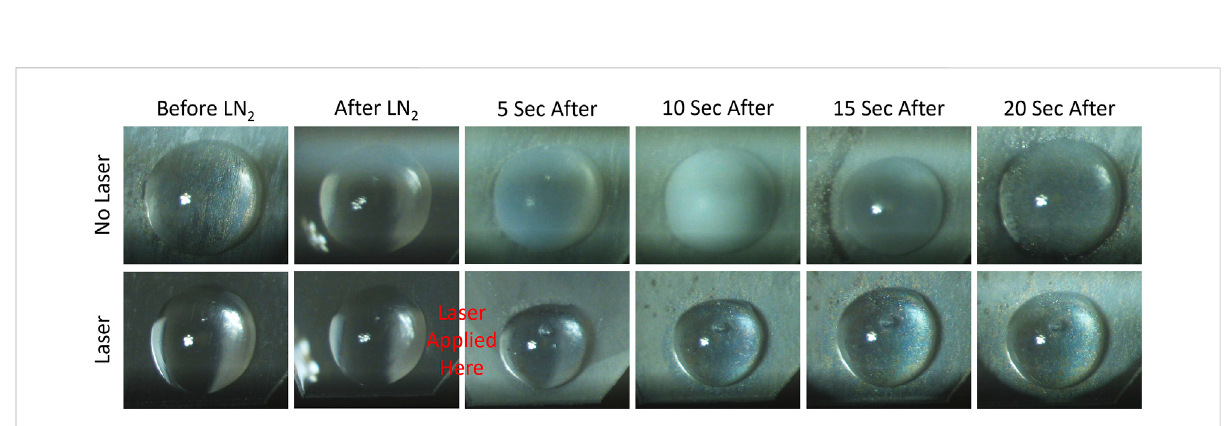
FIGURE 8 Microdroplet laser rewarming of TiN NPs in CPA solution. The top row displays rewarming a vitri fi ed microdroplet (1 μ L) without laser. Devitri fi cation, ice formation, appears as a cloudy white color. The bottom row shows a vitri fi ed microdroplet with laser rewarming and no devitri fi